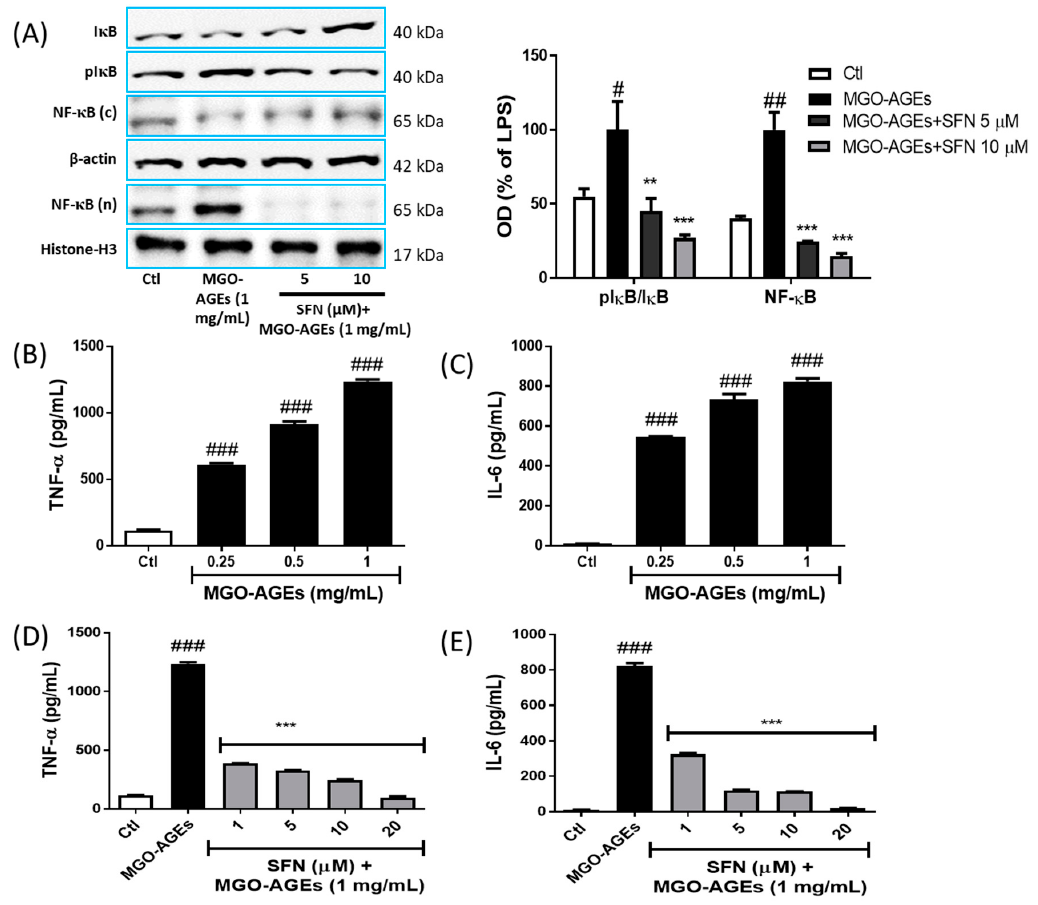
Figure 4. SFN pretreatment reduced MGO-AGEs-mediated NF- κ B translocation and proinflammatory cytokine secretion in microglial cells. BV2 cells were pretreated with SFN followed by MGO-AGEs (1 mg / mL) treatment (1 h for NF- κ B and 24 h for proinflammatory cytokines). Cytosolic (c) and nuclear (n) protein expression and densitometric analysis results of NF- κ B, I κ B, and pI κ B ( A ). Secreted levels of TNF- α and IL-6 in BV2 cells following treatment with di ff erent concentrations of MGO-AGEs ( B , C ). Secreted levels of TNF- α and IL-6 in BV2 cells pretreated with SFN and treated with MGO-AGEs ( D , E ). ** p < 0.01 and *** p < 0.001 indicate significant di ff erences compared with AGE alone, whereas # p < 0.05, ## p < 0.01, and ### p < 0.001 indicate significant di ff erences compared with an untreated control